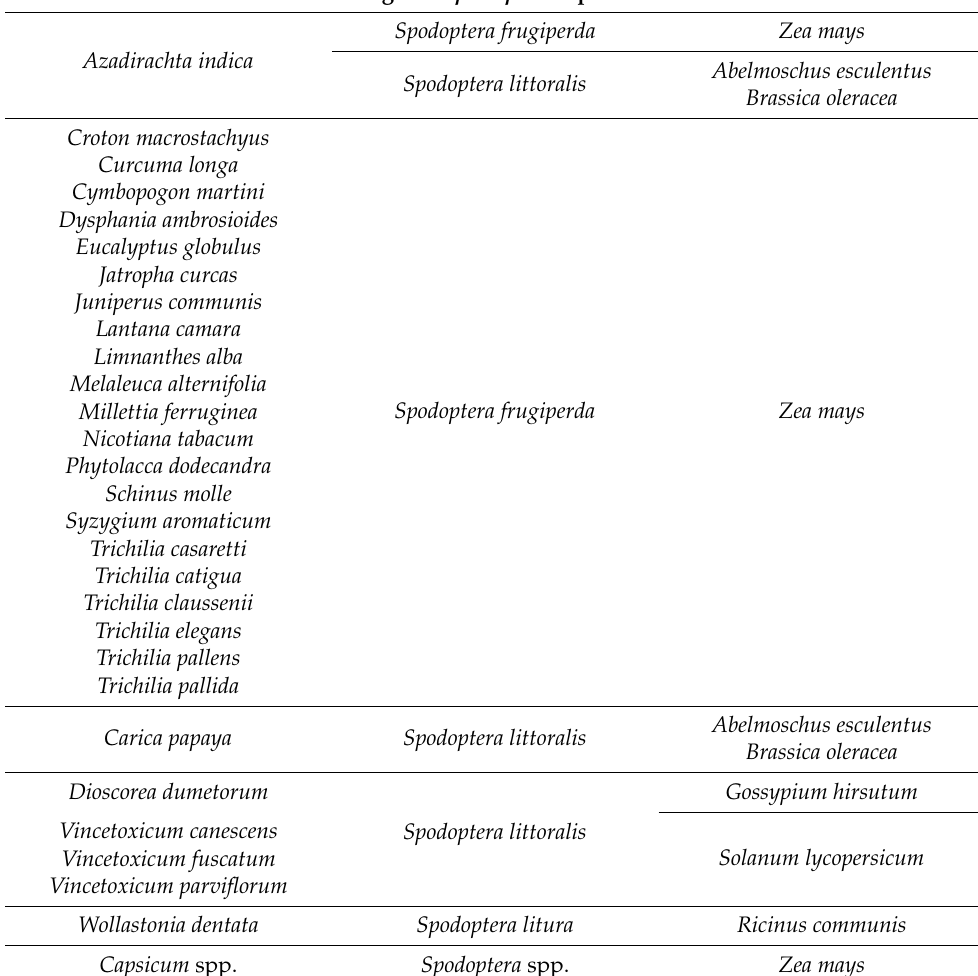
(Table S2): 279 species belonging to 62 botanical families, for S. littoralis , 205 species belong- ing to 48 families for S. frugiperda , 80 species (28 families) for S. litura , 6 species (4 families) for Spodoptera exigua (Hübner), 2 species (one family) for S. eridania (Stoll) and only one for S. ornithogalli (Guen é e) and S. exempta (F.). In the case of S. frugiperda , some of the